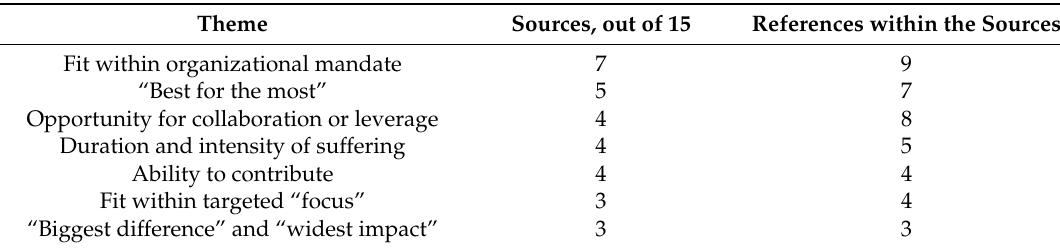
Table 1. Summary and frequency of nodes (identified occurring